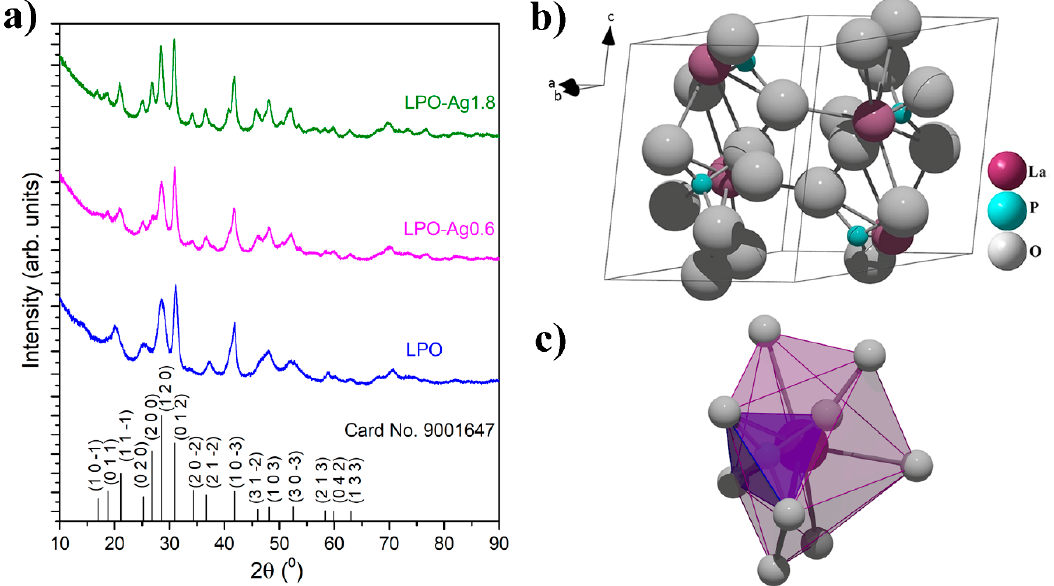
Figure 2. ( a ) XRD patterns of the representative LPO, LPO–Ag0.6, and LPO–Ag1.8 samples. The diffraction peaks are indexed according to the Crystallography Open Database - COD card No. 9001647. Lanthanum phosphate (LaPO 4 ); ( b ) unit cell; and ( c ) coordination polyhedron around La 3+ .